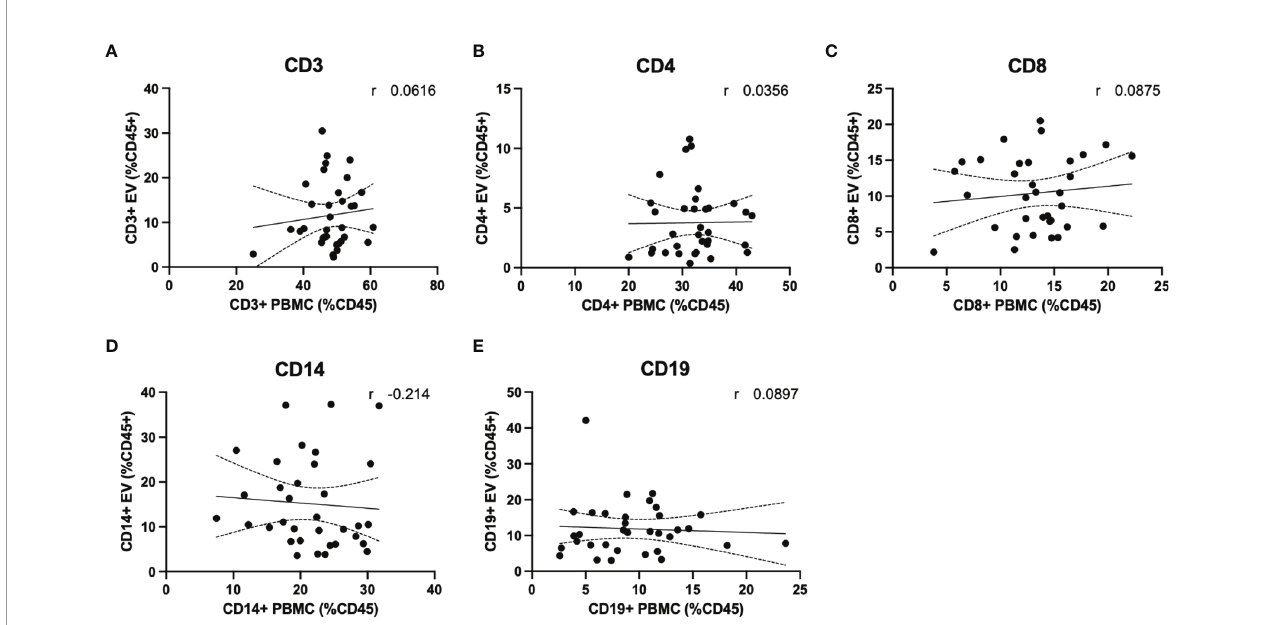
FIGURE 5 | Circulating PBMC immunophenotype does not correlate with circulating lymphocyte-derived EVs. Plasma levelsofEVs derived from (A) totalT cells, (B) CD4+ T cells and monocytes, (C) CD8+ T cells, (D) monocytes and (E) B cells are not correlatedwith circulating levelsof circulating parent lymphocyte